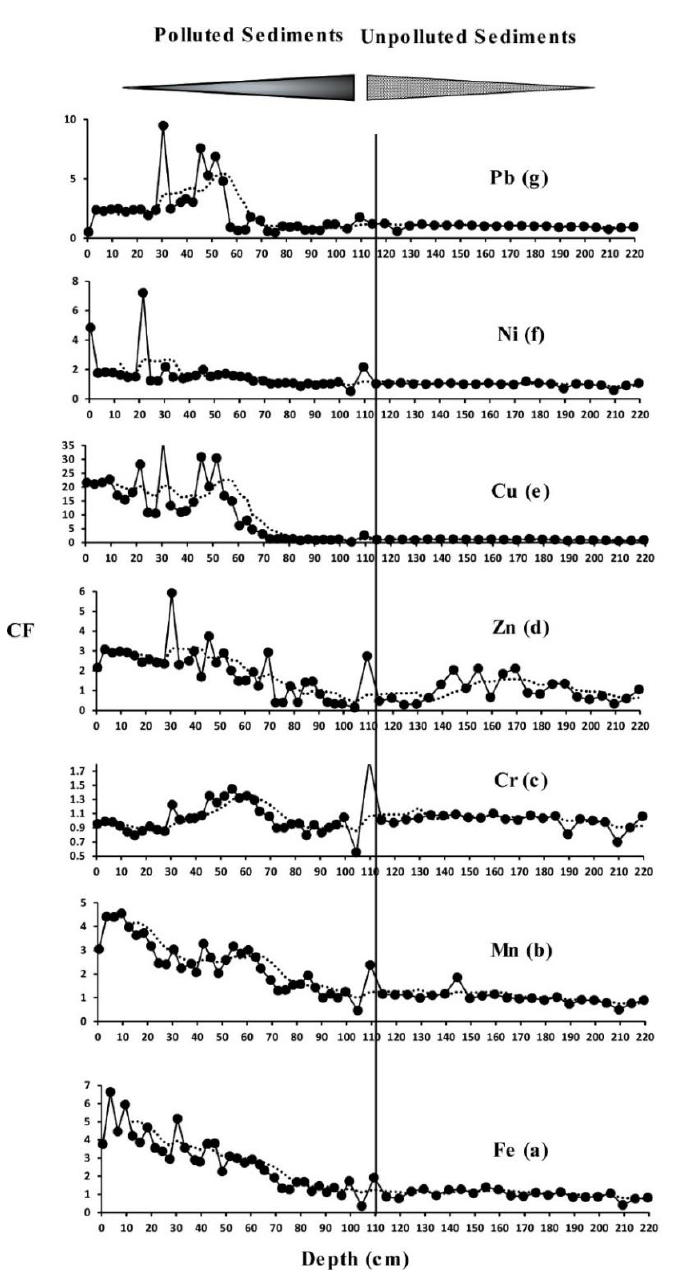
Figure 4. ( a , b ) Vertical distribution of contamination factor ( c – g ) for metals in the Salam1 core from Al − Salam Lagoon along the Jeddah coast, Saudi Arabia. (Trend line of 5 Average is shown by dots).